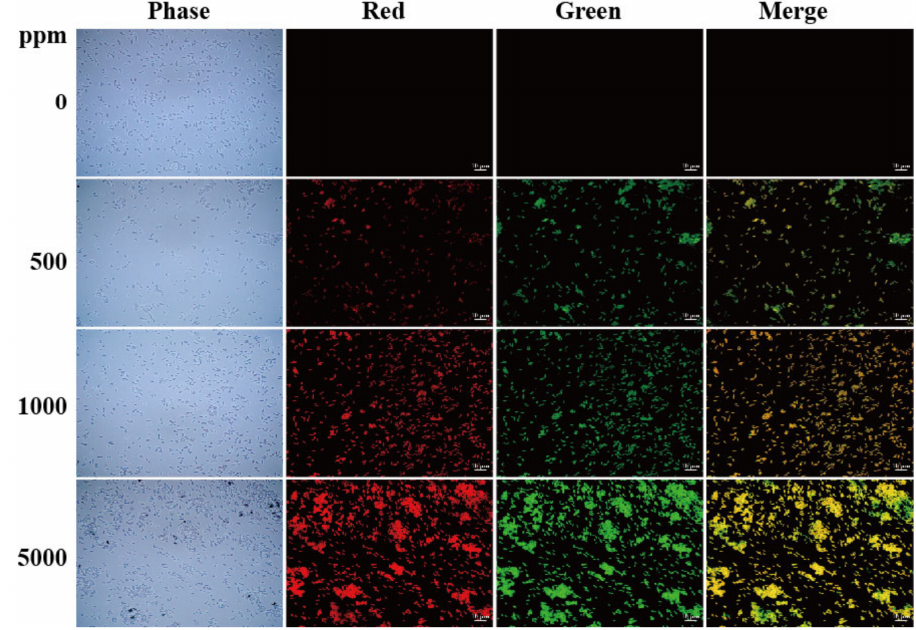
Figure 4. Fluorescence images of B. subtilis stained with N-CQDs at different concentrations. Bacillus cells were stained with 500, 1000, and 5000 ppm N-CQDs. Control was cells not stained with N-CQDs. TRITC filter detected red fluorescence, whereas FITC filter detected green fluorescence. Scale bar represents 10 µ